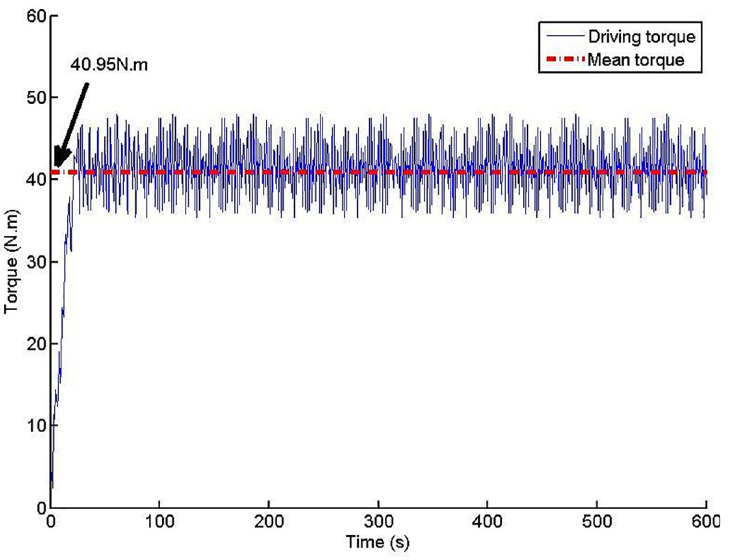
Fig 12. Driving torque